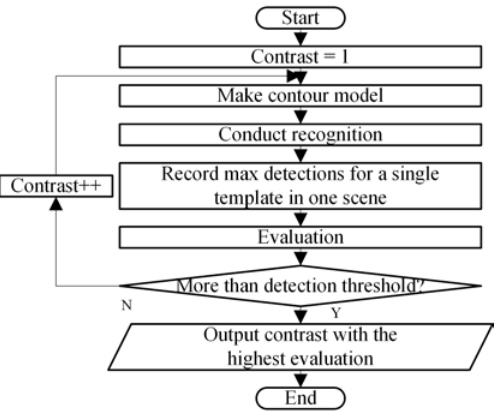
Figure 3. Contour models (marked with red lines) made by different contrast values; the number of contours decrease as the contrast increases. Less contours in a model increase the number of detections that have to be matched and thus result in a longer time taken for matching.